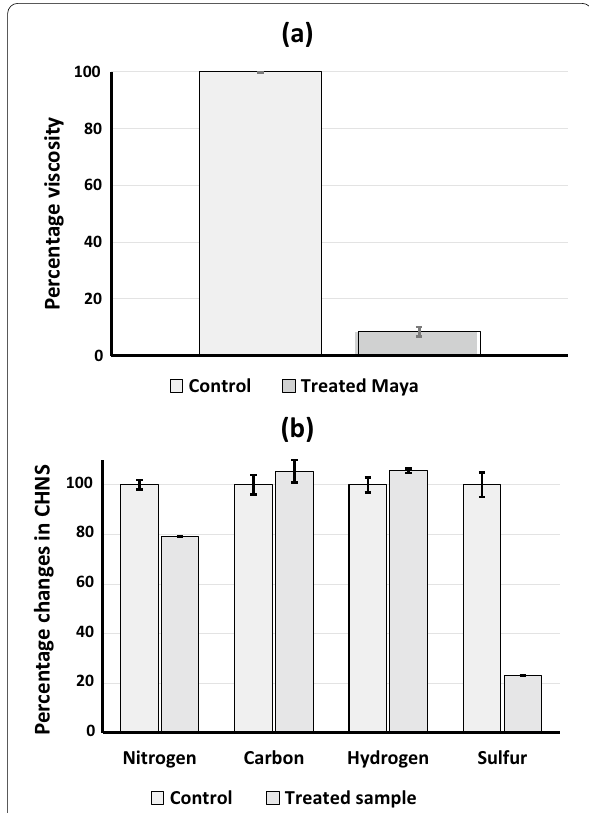
Fig. 7 Viscosity reduction of heavy crude oil by the microbial consortium. a Percentage reduction in viscosity of Maya heavy crude oil due to upgradation by microbial consortium. b Elemental changes in Maya crude oil composition due to upgradation by microbial